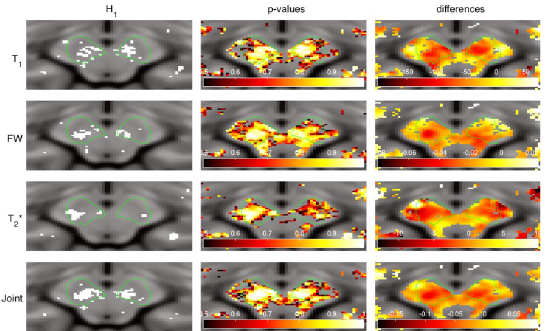
Fig 5. Null hypothesis rejection indicator (first column, white = rejected), raw p-values (middle column) and differences between estimators (last column) for each metric selected for the analysis.